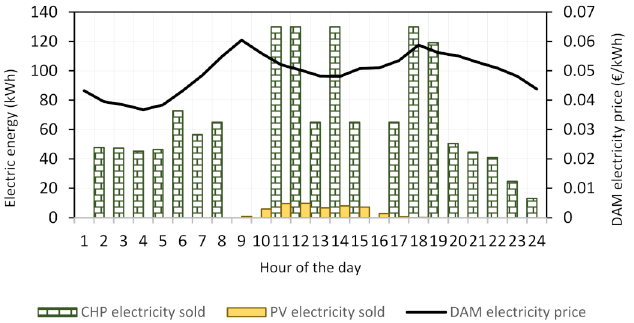
Figure 19. Bidding strategies of the ILEC on DAM obtained with economic optimization for 18 January